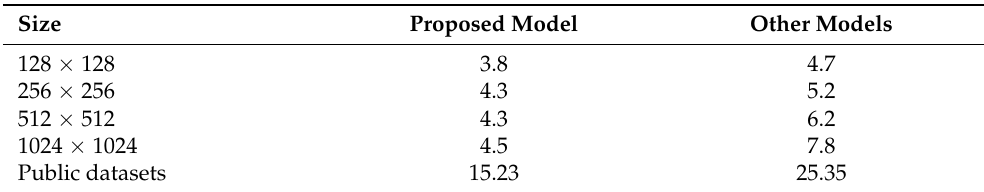
Table 7. Expected performance—decompression computing times (in ms) compared with those of other